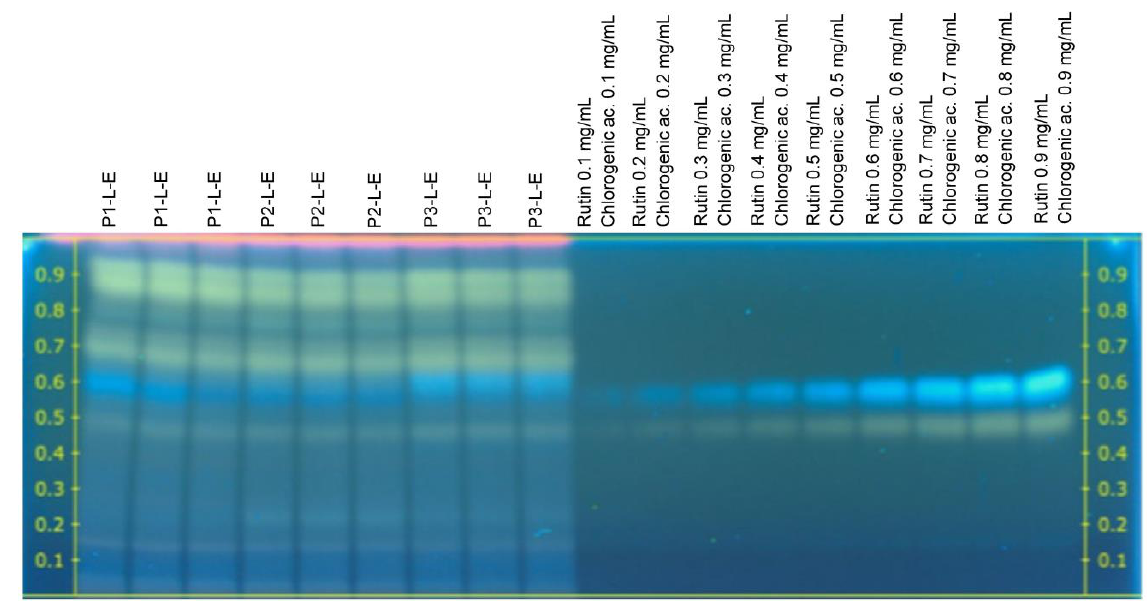
Figure 2. HPTLC chromatogram of ethanolic extracts from leaves of Cosmos sulphureus under visible light in the transmittance mode developed using ethyl acetate (100): formic acid (11): acetic acid (11): water (26) ( v / v / v / v ) as the mobile phase after derivatization with 1% 2-aminoethyl diphenyl borate ( w / v ).